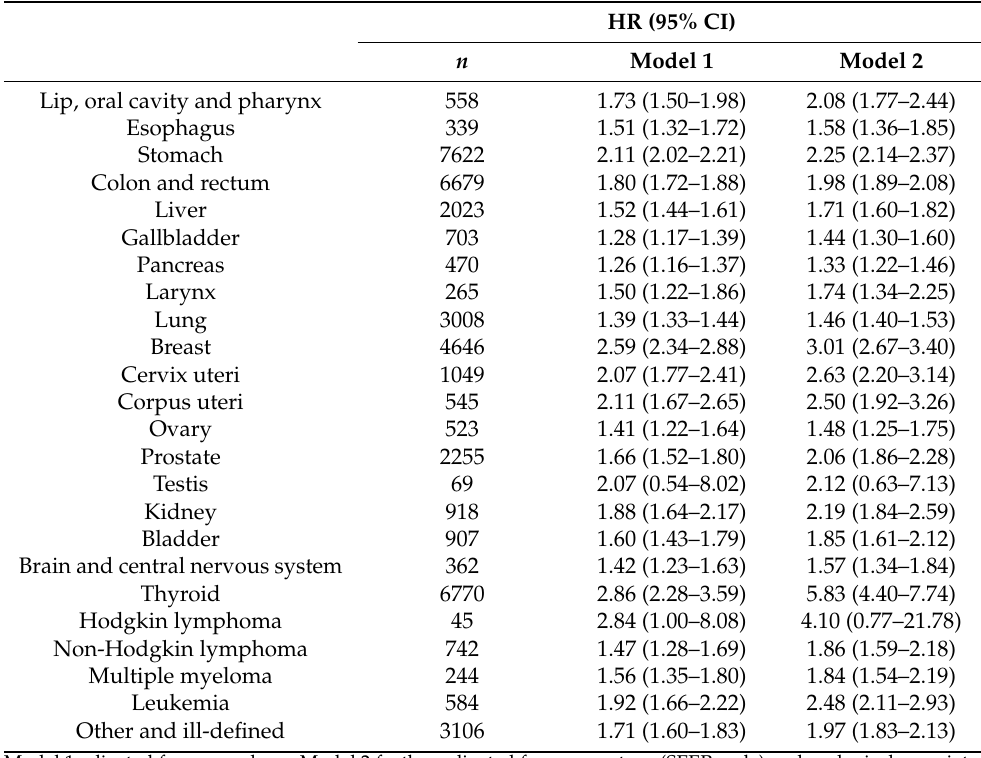
Table 4. HRs for all-cause mortality by an increase of 1 standard deviation in PM 10 exposure stratified by cancer